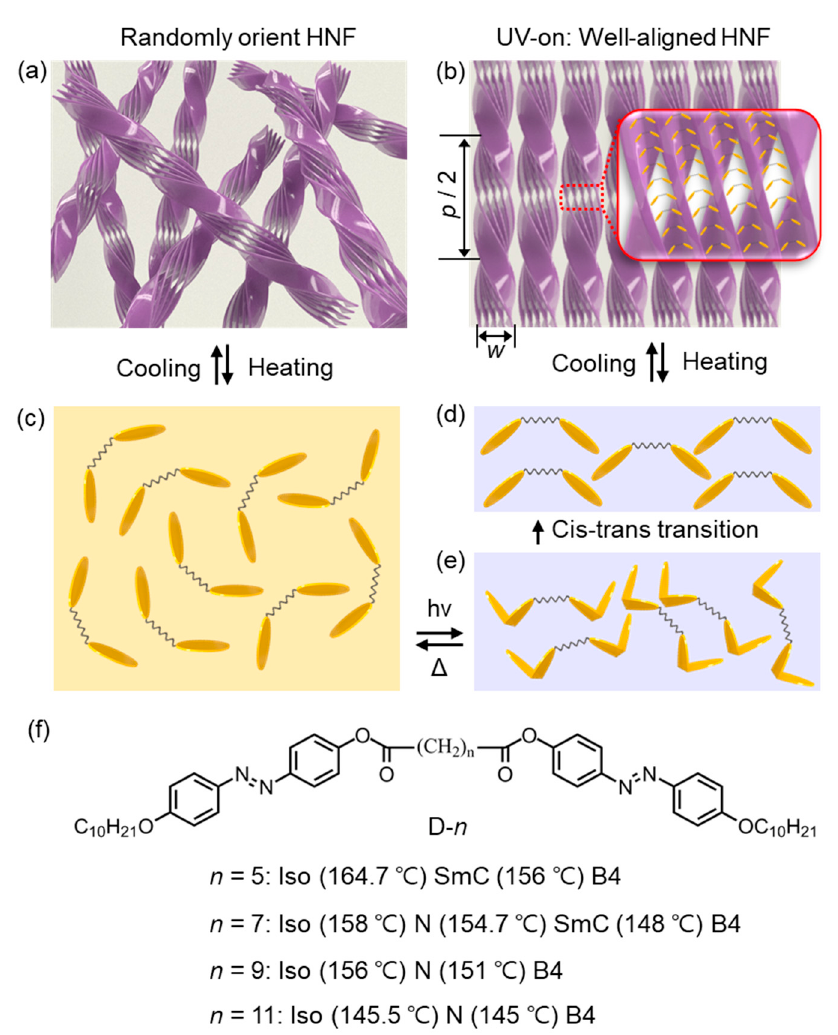
Figure 9. Schematic illustrations of the photoaligning process of azobenzene containing bent-shaped molecules and the HNF made from them. ( a ) When HNFs are grown without UV light, they are randomly oriented. ( b ) However, if HNFs are made under UV-shining conditions, vertically oriented HNFs are formed. ( c ) Without UV exposure, LC molecules are randomly oriented. ( d , e ) However, once UV light is irradiated from top to bottom, molecules are photoisomerized first and then reoriented following the light-propagating direction. ( f ) Chemical structure of D-n molecules and their thermal phase transition. Reprinted with permission from [7], Copyright 2019, Springer Nature.